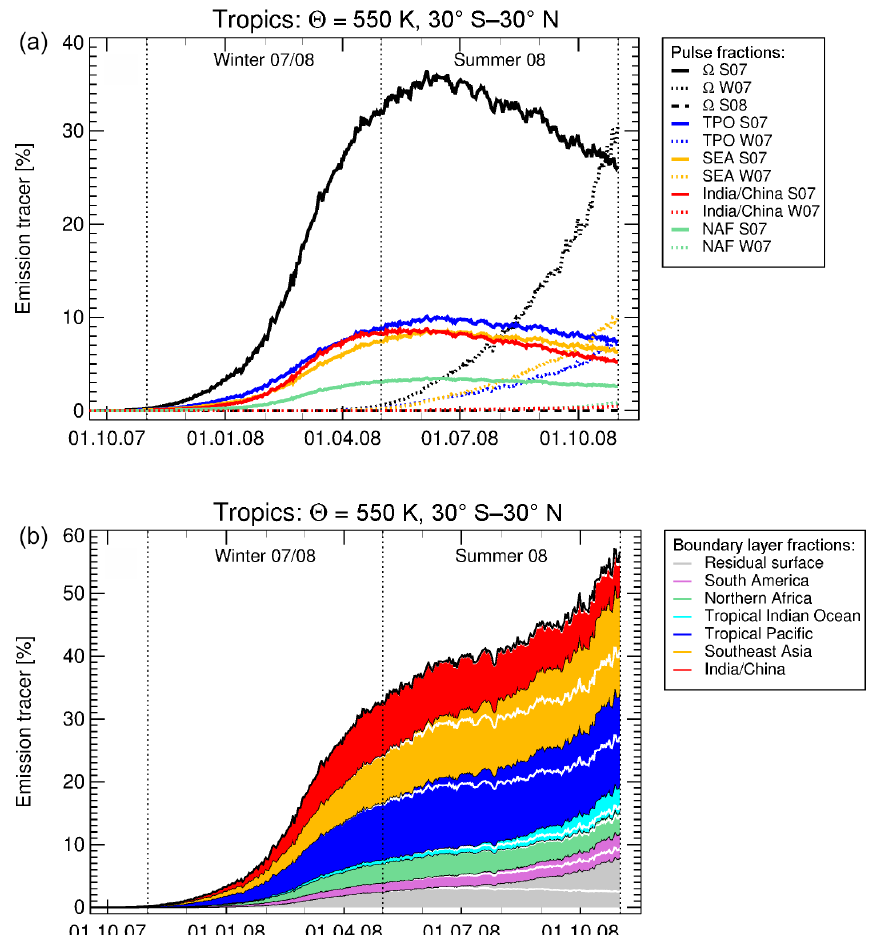
Figure 13. (a) The contribution of the three different time pulses S07, W07, and S08 (each set for a time period of 6 months marked by the vertical dotted lines) for the entire Earth’s surface ( (cid:127) S07 , (cid:127) W07 , (cid:127) S08 ) to the tropical pipe between 30 ◦ S and 30 ◦ N at 550K potential temperature from 1 October 2007 until the end of the simulation period (31 October 2008) (black lines). Emission tracers released during S08 have no contribution to the tropical pipe at 550K by October 2008. The contribution of several tracers of air mass origin to the individual pulses are shown by coloured lines. (b) Contribution of different emission tracers for the tropical Pacific Ocean, Southeast Asia, India/China, South America, northern Africa, tropical Indian Ocean, and the residual surface (all other regions of the Earth’s surface) to the tropical pipe between 30 ◦ S and 30 ◦ N at 550K potential temperature from 1 October 2007 until the end of the simulation period. The contribution of the time pulses for the different emission tracers are marked by thin white lines for S07 and by thin black lines for